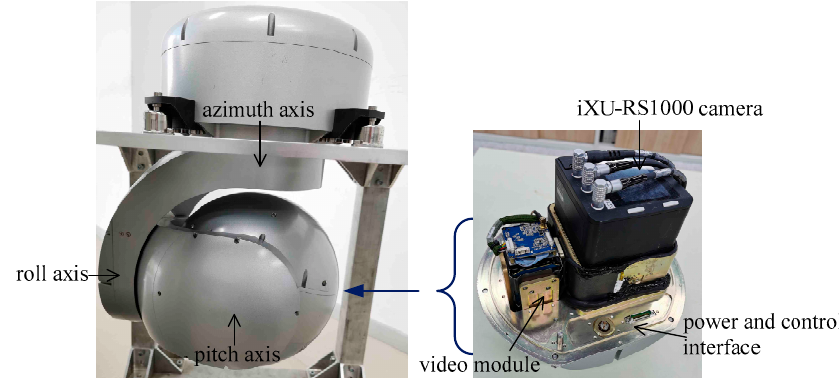
Figure 12. Three-axis ISP and iXU-RS1000 camera.